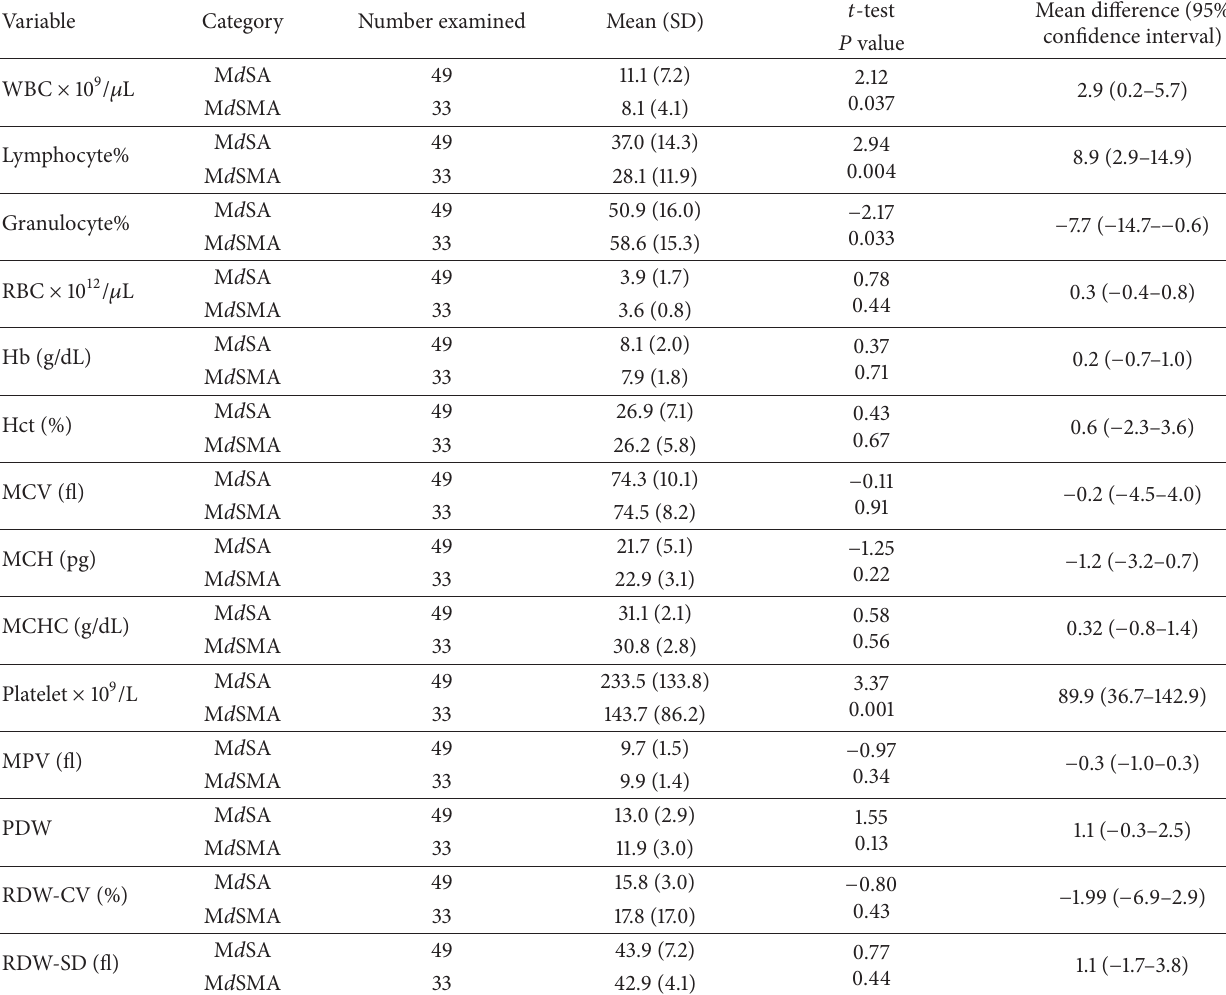
Table 4: Variation in mean haematological values in children with M d SA and M d